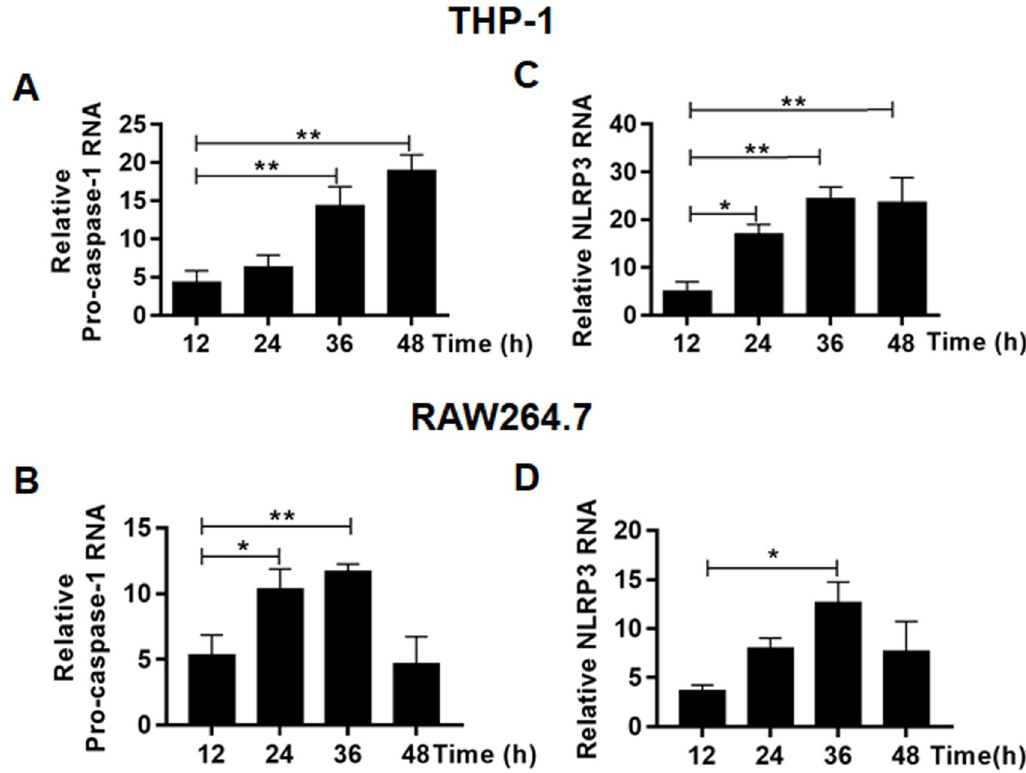
Fig 7. Upregulation of the inflammasome components in ZIKV-infected macrophages. Total RNA was prepared at various time points p.i. from THP-1 and RAW264.7 cells infected with 0.1 MOI of ZIKV for realtime RT-PCR to measure mRNA transcript numbers of pro-caspase-1 ( A & B ) and NLRP3 ( C & D ). The experiments were performed in triplicates and the data were shown as mean+SD, analysed by unpaired Students t-test. � , P < 0.05; �� , P < 0.01. ns, no significance.